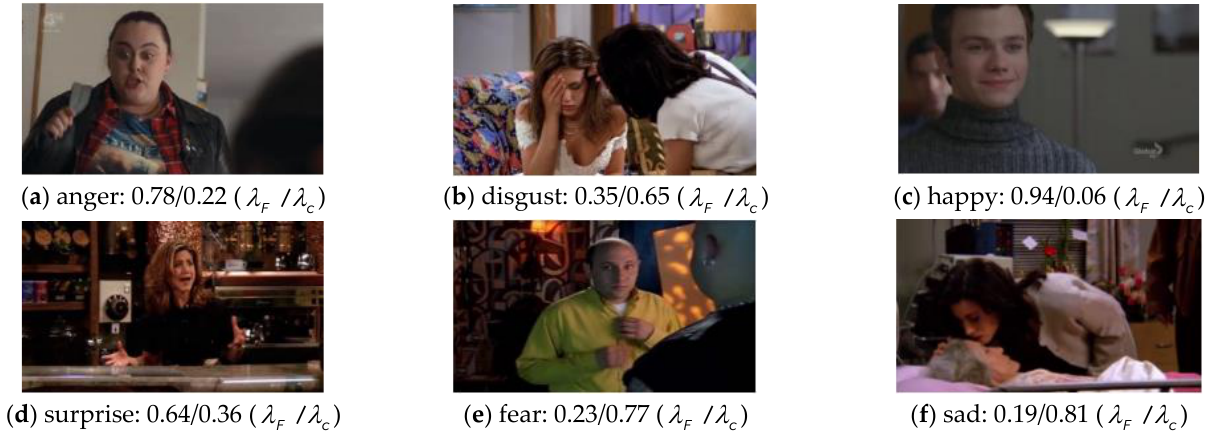
Figure 12. The weights of some samples on the CAER-S dataset.